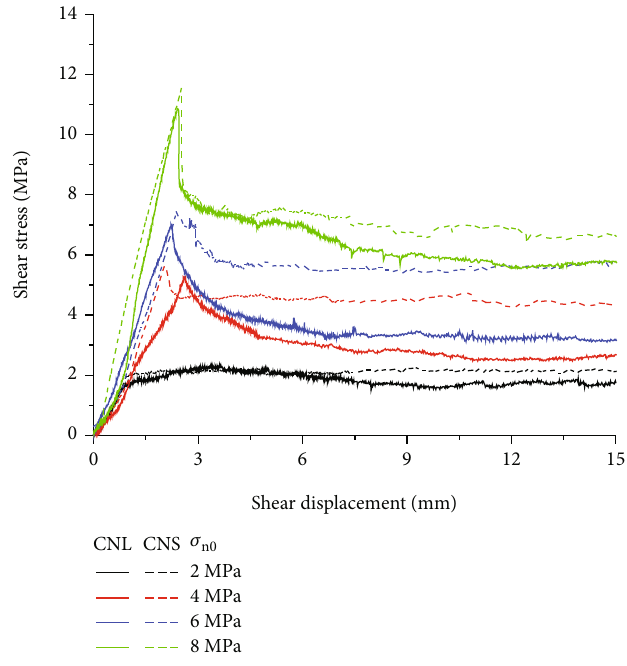
Figure 3: Curves of shear stress with shear displacement.